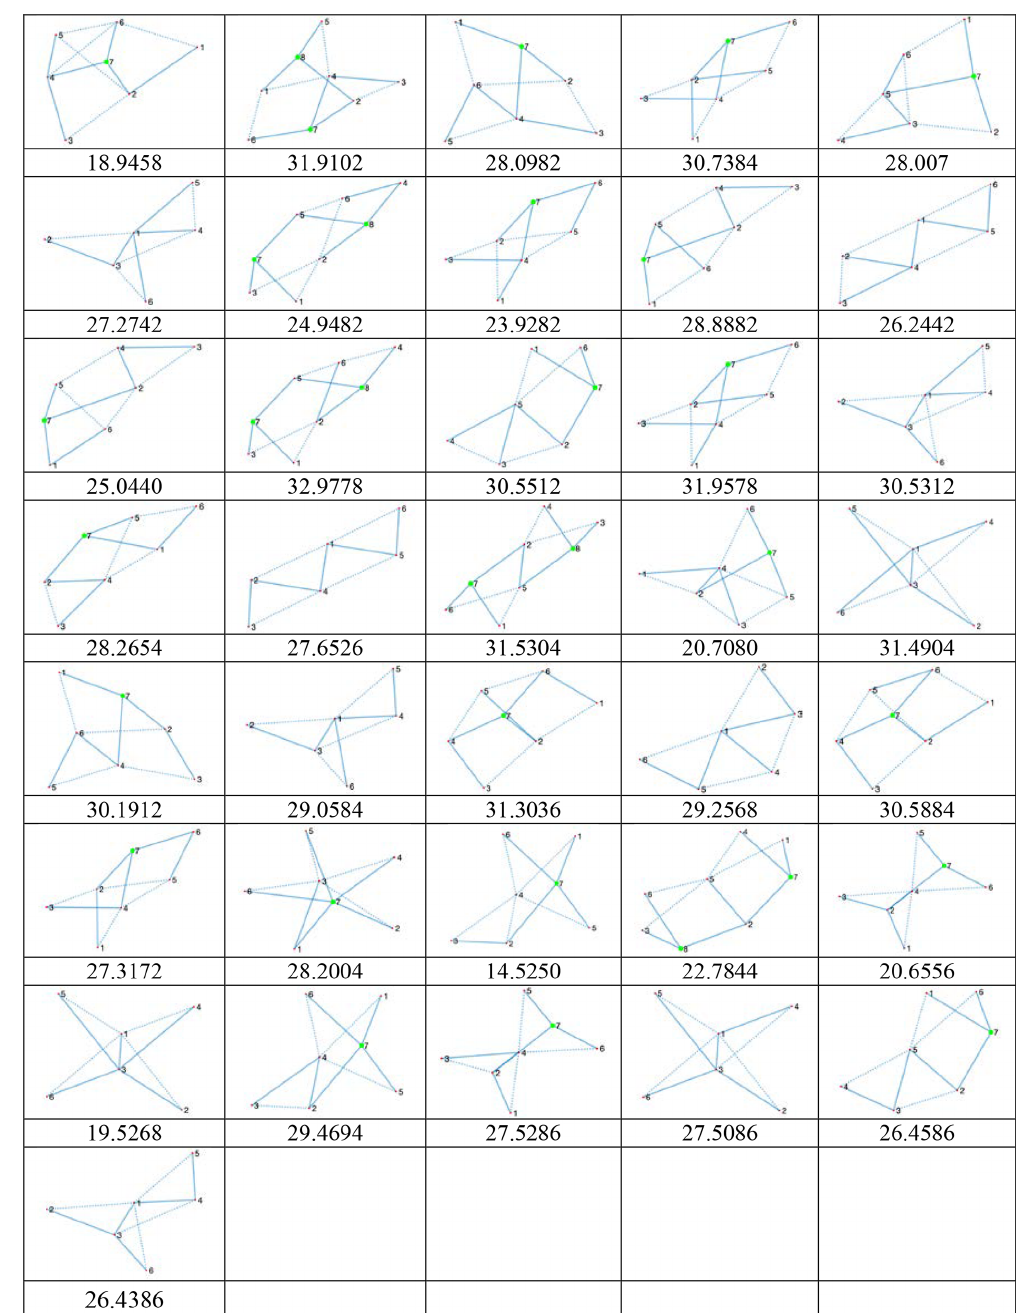
Figure A1. A total of 81 displacement graphs of 6bar 1 DOF planetary gear